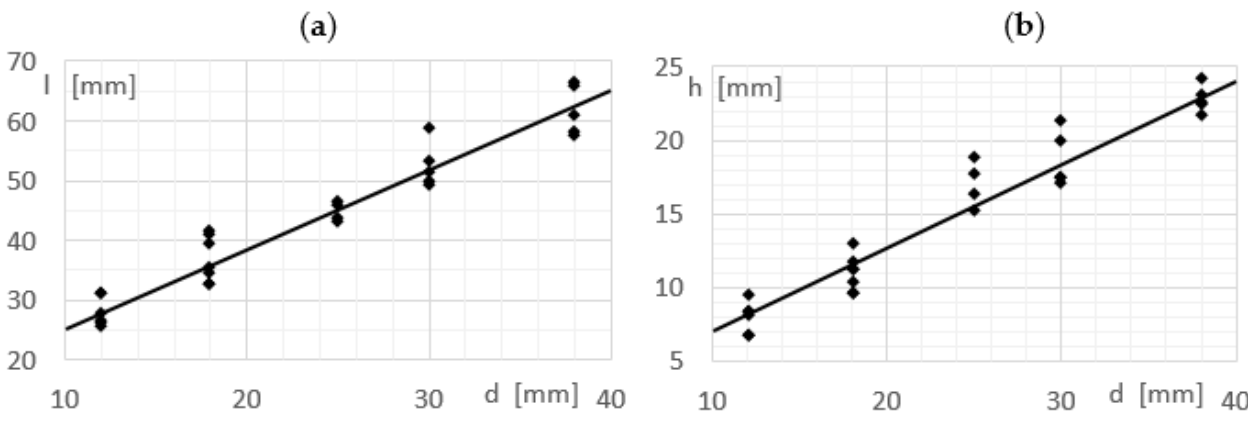
Figure 20. Influence of shedder size on ( a ) length of the vortex zone l ( b ) distance from axis h.